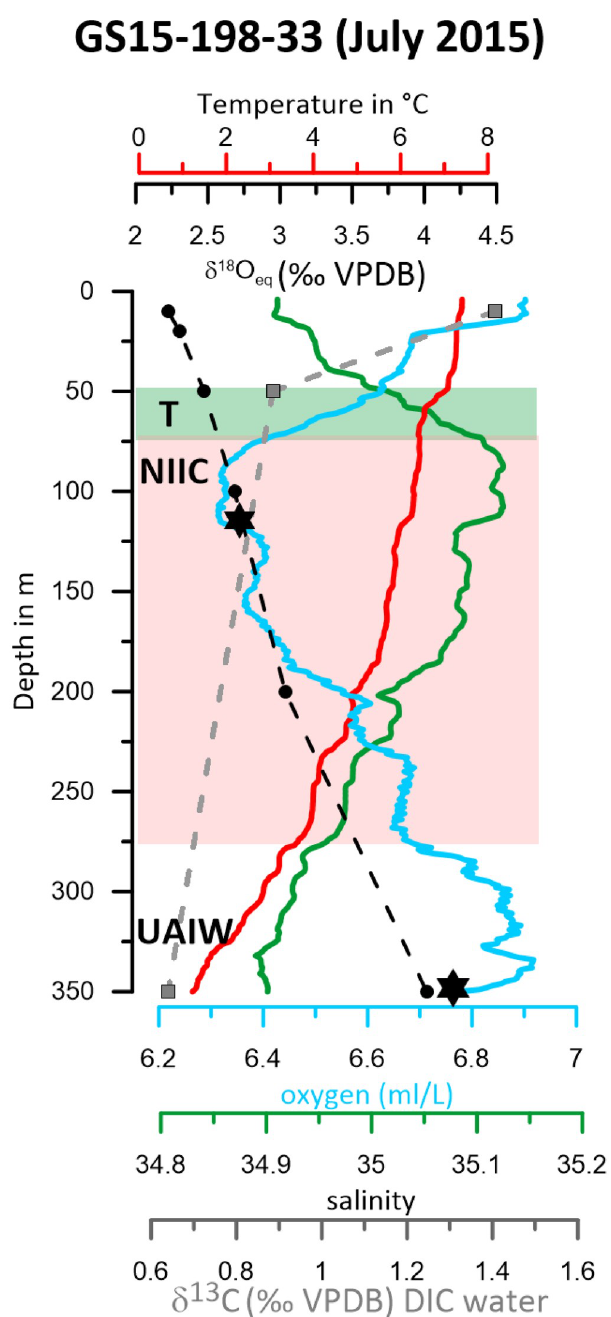
Fig 2. Water mass properties at the core location on the North Iceland shelf. Measured temperature, salinity, and oxygen profiles from July 2015 during research cruise GS15-198. Black stars denote apparent calcification depth (the depth where δ 18 O calcite matches δ 18 O eq ) of planktic and benthic foraminifera. The calculated δ 18 O eq in the water column is based on the measured temperature and δ 18 O of the water from the CTD data; (black circles). There is an offset between the δ 18 O calcite and δ 18 O eq for benthic species M . barleeanum . The stable isotope data for dissolved inorganic carbon ( δ 13 C of DIC, δ 13 C DIC ) in the seawater is shown as grey squares. The extent of Atlantic Water ( > 34.9 and > 4˚C) of the NIIC is outlined in the red box. Note that the Atlantic Water occupies intermediate depths in the water column, from approximately 75–275 m. Thermocline waters (T) are indicated between 50-75m as a green box. The surface is occupied by a fresh, relatively warm water mass. The bottom of the water column 275–350 m is dominated by colder and fresher Upper Arctic intermediate waters (UAIW).